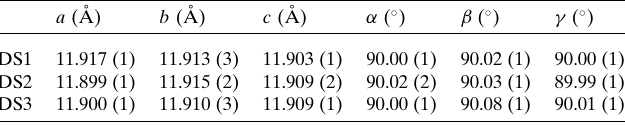
Table 7 Free unit-cell refinement with distortions obtained from monoclinic unit- cell symmetry constraint induced during simultaneous unit-cell and distortion